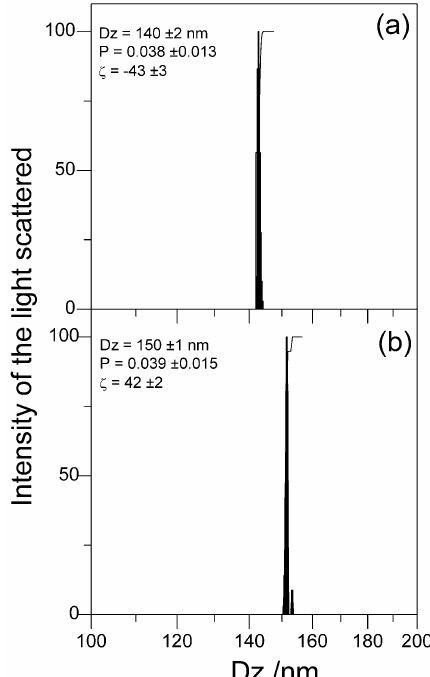
Figure 3. The narrow size distributions of the PSS based NPs used in this work as antimicrobials. ( a ) Size distributions for PSS NPs; ( b ) size distributions for PSS/DODAB/Gr NPs. Physical properties for the NPs are quoted in each subfigure: mean zeta-average diameter (Dz), polydispersity (P), and zeta-potential ( ζ ). PSS NP and PSS/DODAB/Gr NP concentrations were 2.4 × 10 10 particles/mL, whereas [DODAB] and [Gr] were 0.01 and 0.001 mM, respectively.